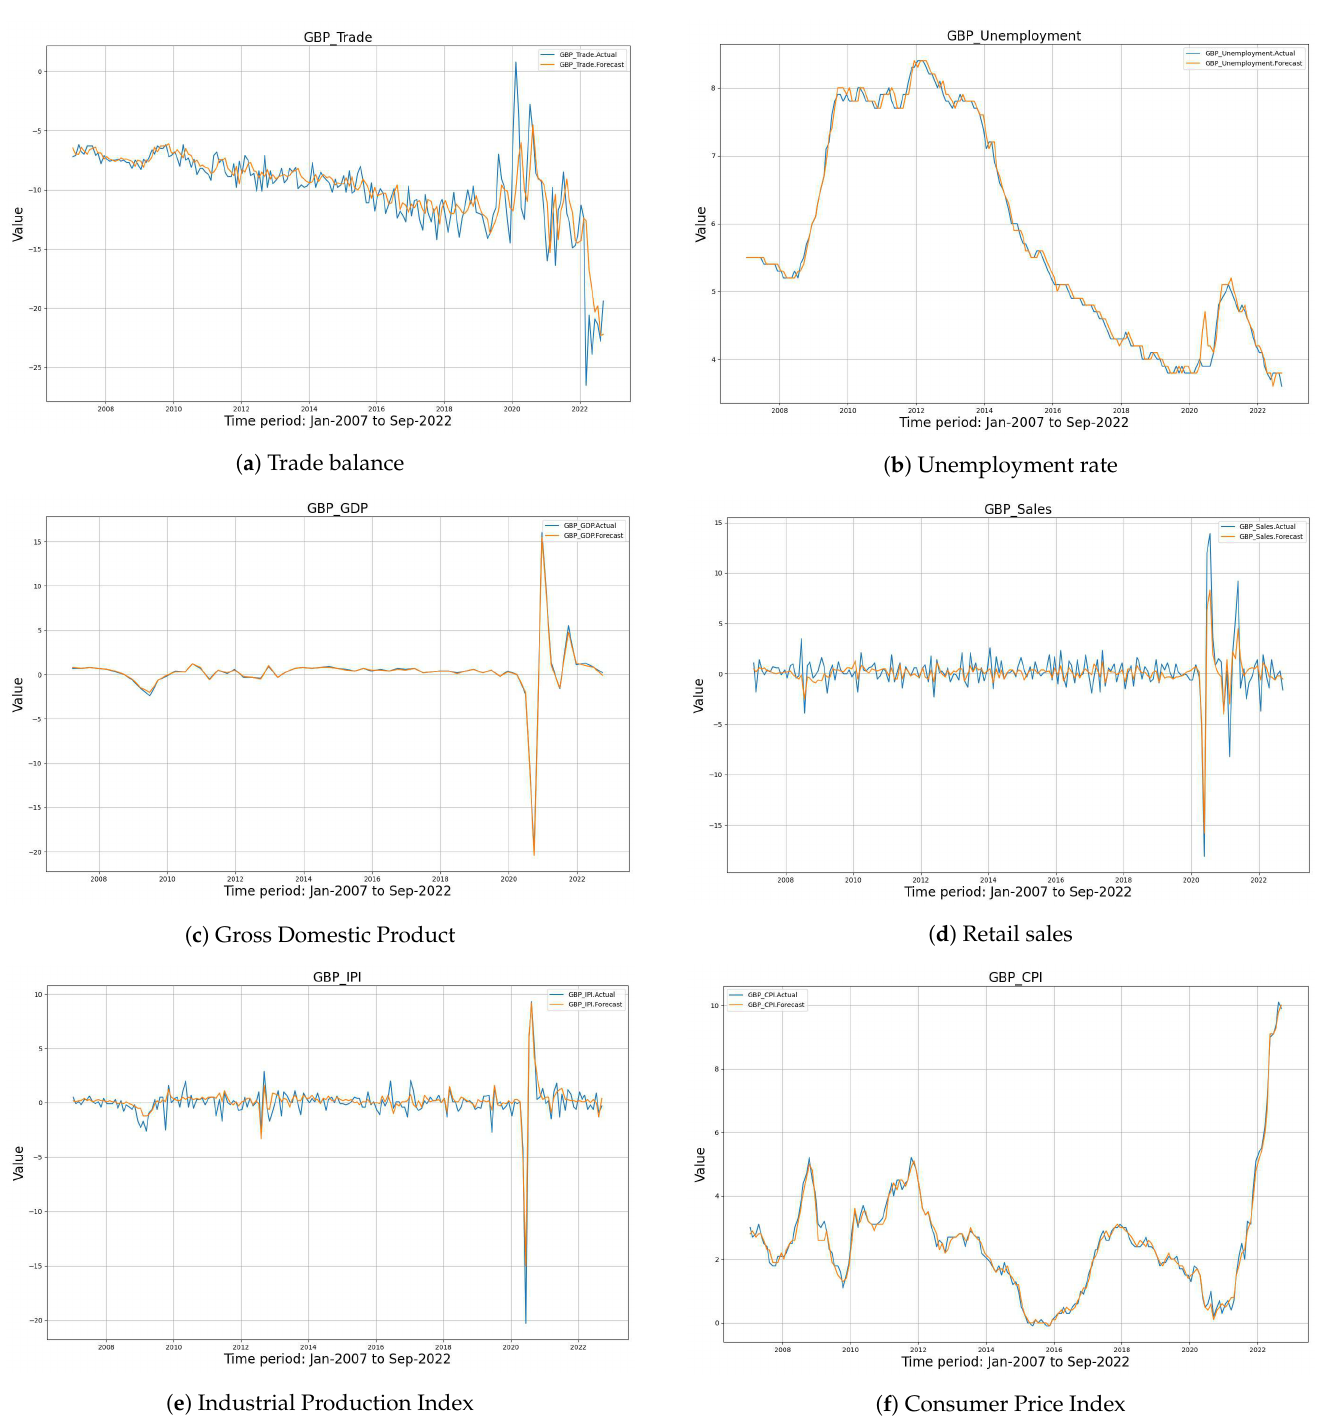
Figure 3. Plot showing the time evolution of the 6 macroeconomic news items from the United Kingdom (UK) for the time period analysed between June 2007 and September 2022. The current value of each time period is marked in blue, and the predicted value in